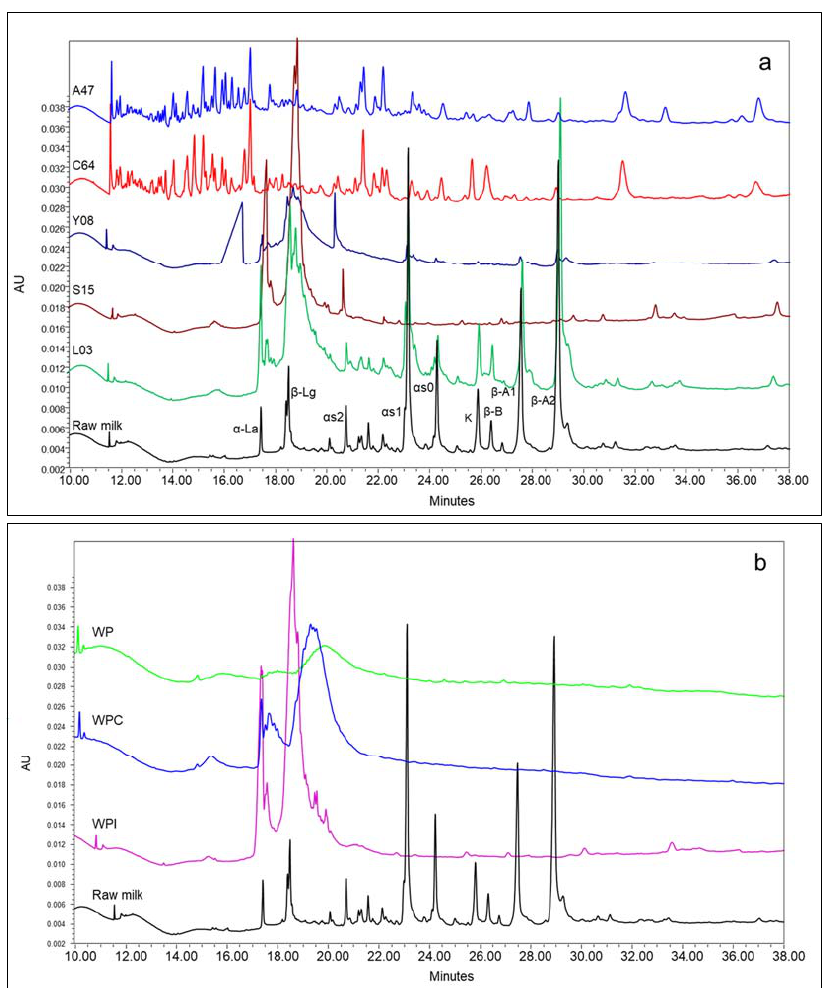
Figure 1. Capillary electrophoresis patterns of: ( a ) commercial sport supplements and; ( b ) control samples. A47: whey proteins obtained by ultrafiltration; C64: hydrolyzed whey protein isolate; Y08: whey protein concentrate; S15: whey protein isolate added with alanine and glutamine; L03: isolated and ultrafiltered whey proteins; WP: whey powder; WPC: whey protein concentrate; WPI: whey protein isolate. Raw milk sample is used as reference for peak identification.